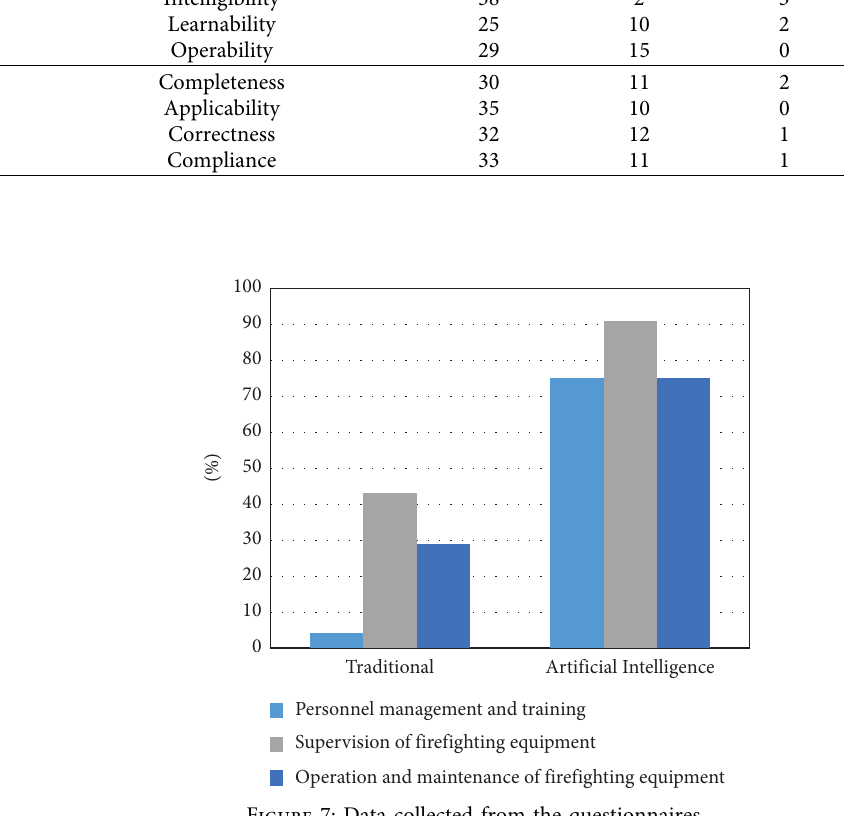
Figure 7: Data collected from the